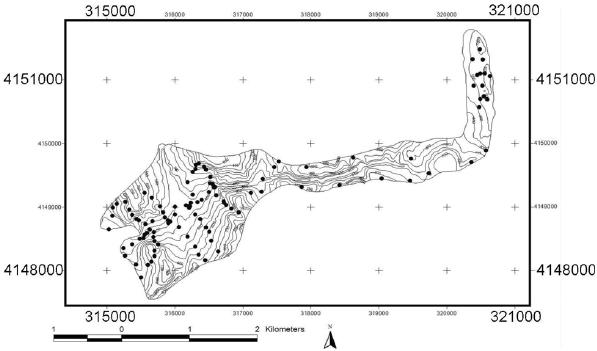
Fig. 3. The location of sample plots in the study area at the Yazili